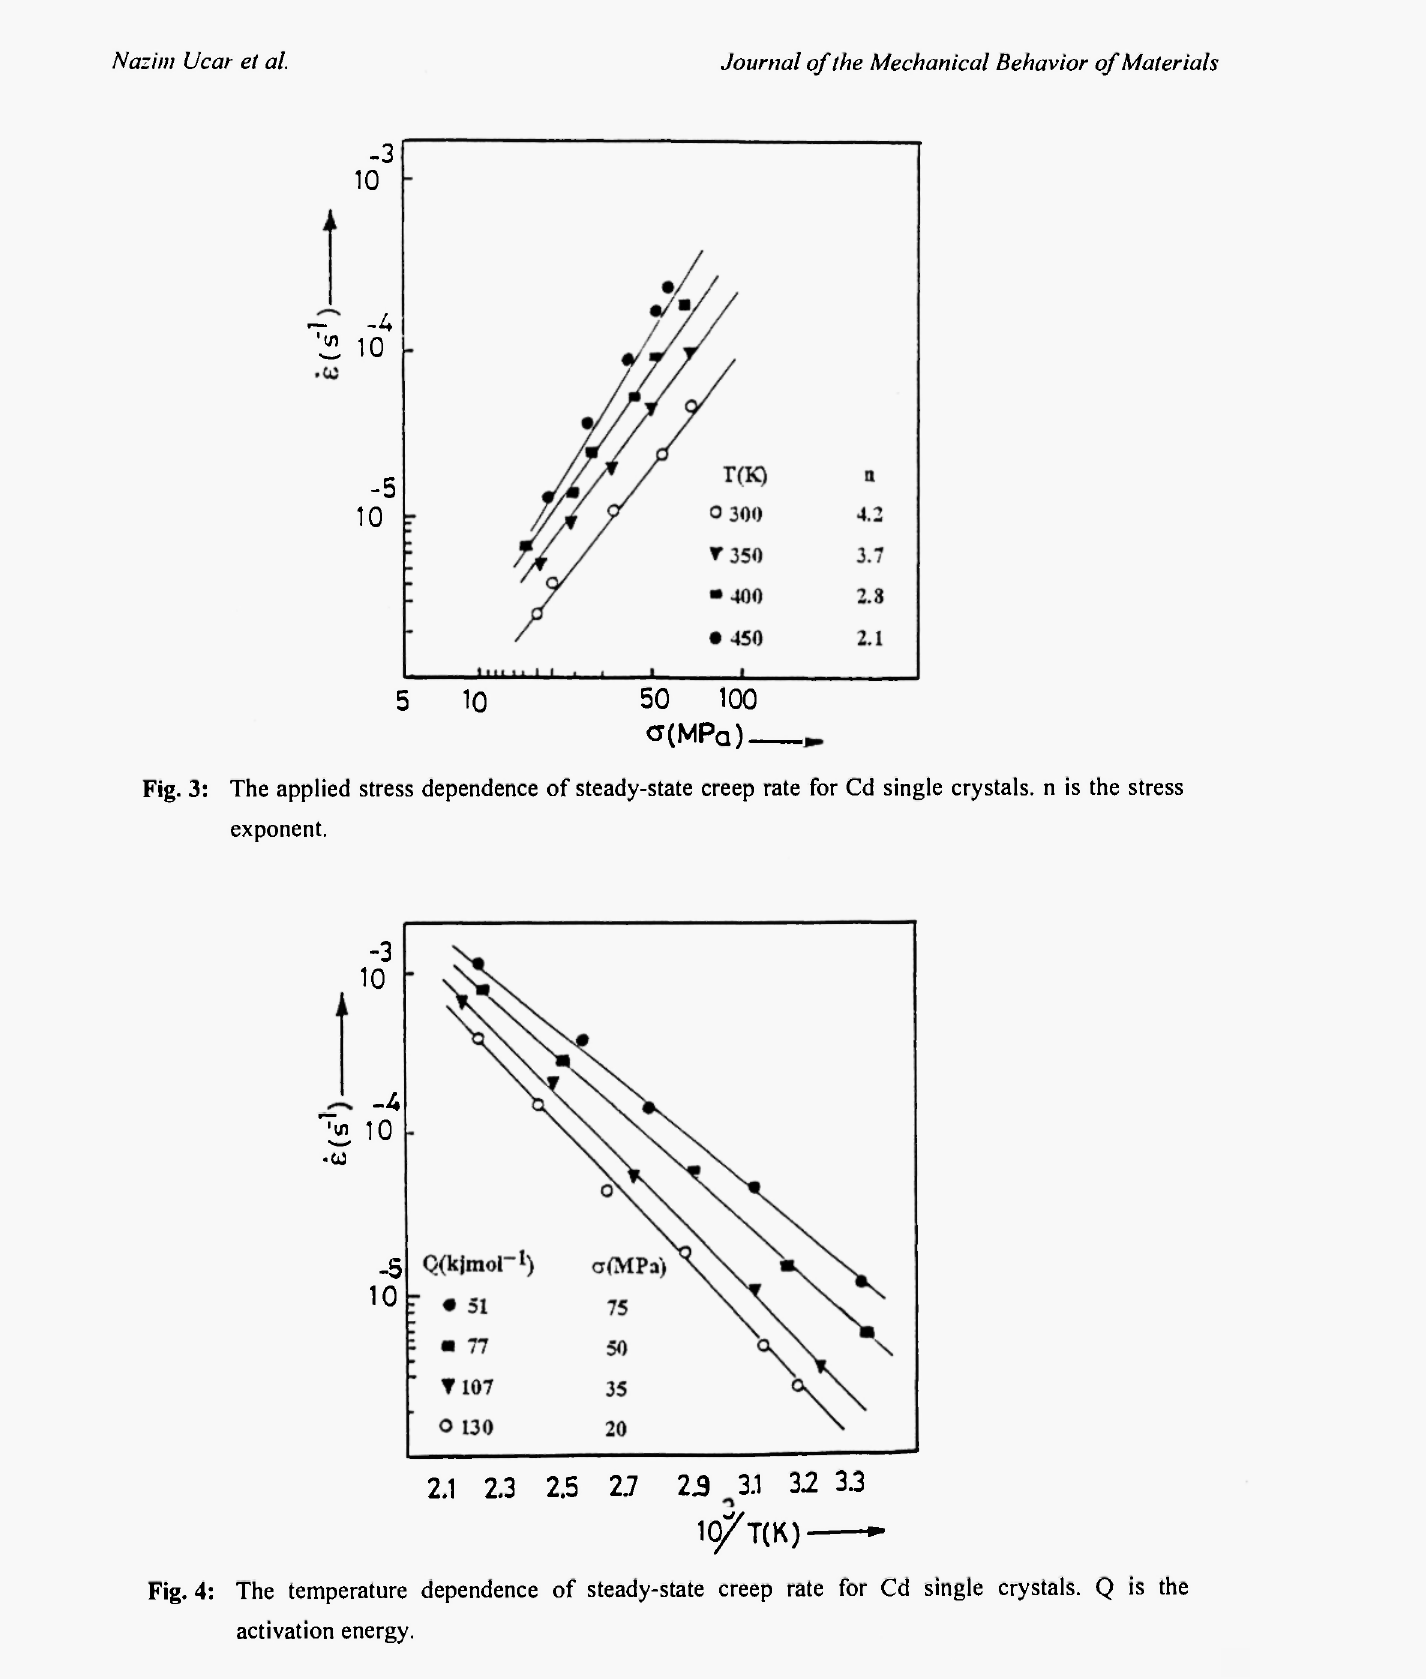
Fig. 4: The temperature dependence of steady-state creep rate for Cd single crystals. Q is the activation